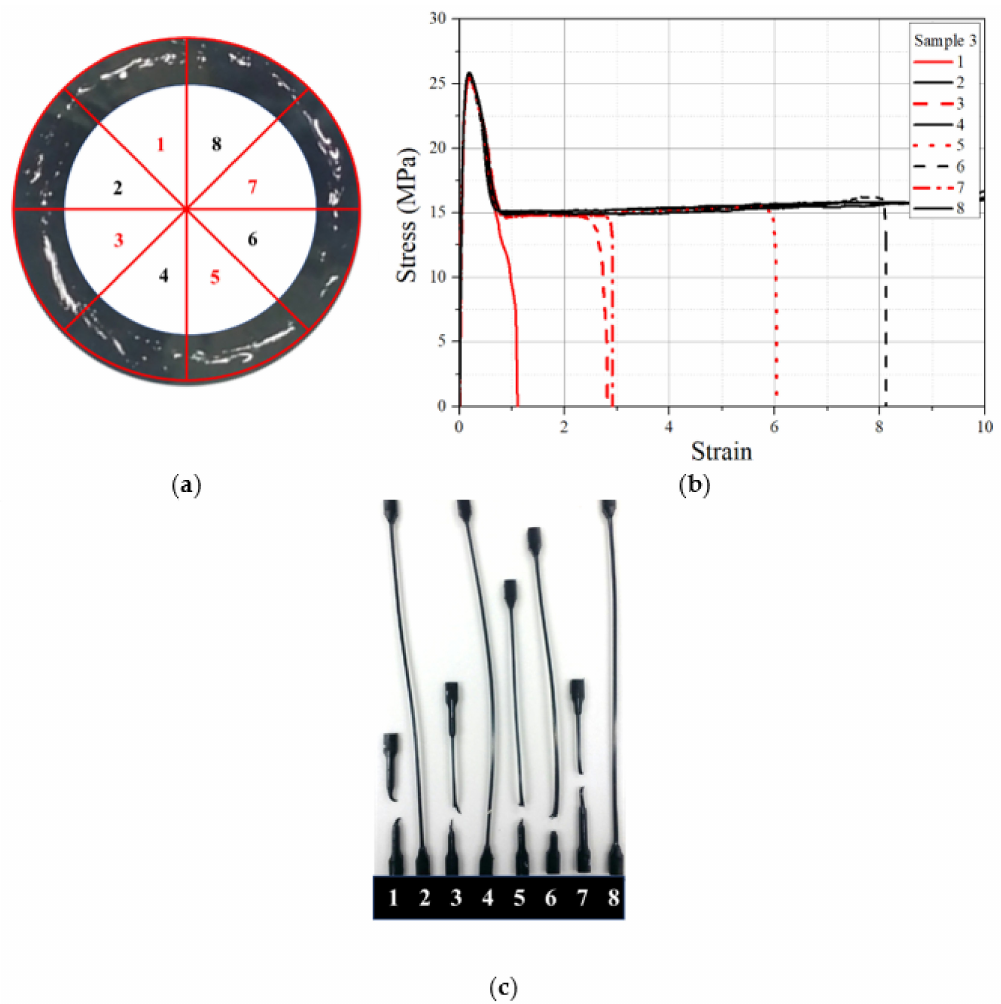
Figure 14. The 12 mm thick tensile specimens from pipe sample 3. ( a ) The eight sector locations, ( b ) tensile stress–strain curve of each specimen, and ( c ) tested specimen.